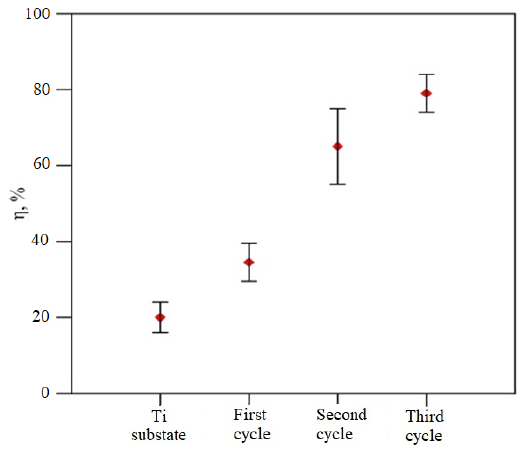
Figure 8. Depth recovery of the Ti substrate and the Ti-Ta coatings formed after each cycle.